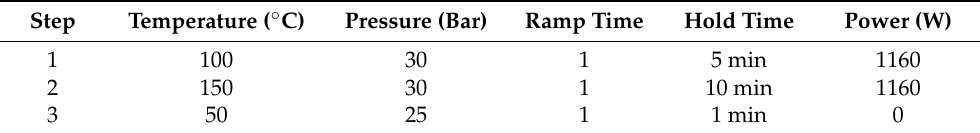
Table 1. Operating conditions for the microwave digestion system.